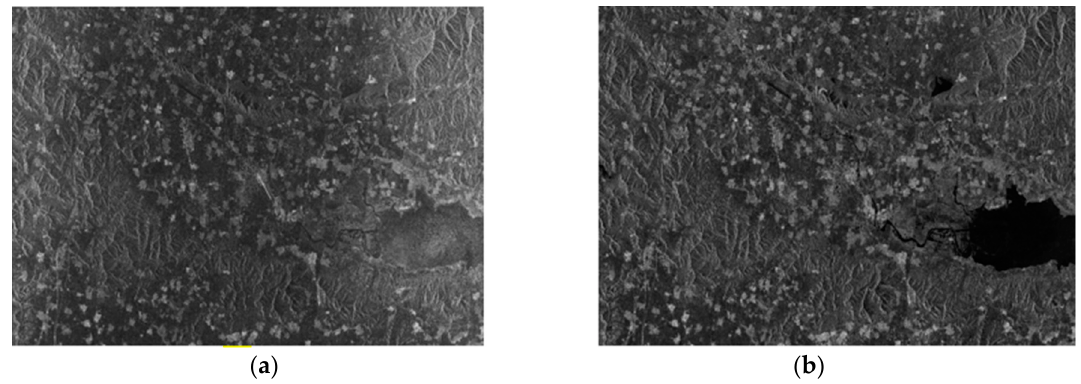
Figure 7. Experimental data: ( a ) the master image of the experiment; ( b ) the slave image of the experiment. The main parameters of the data used in the experiment are shown in Table 2. Table 2. The basic Information about the two GF-3 SAR images employed in the experiment.